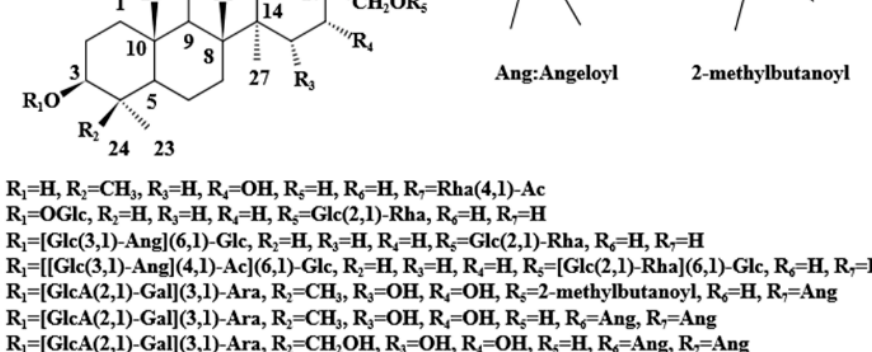
Figure 7. Chemical structure of the saponins identified from X. sorbifolia husks .